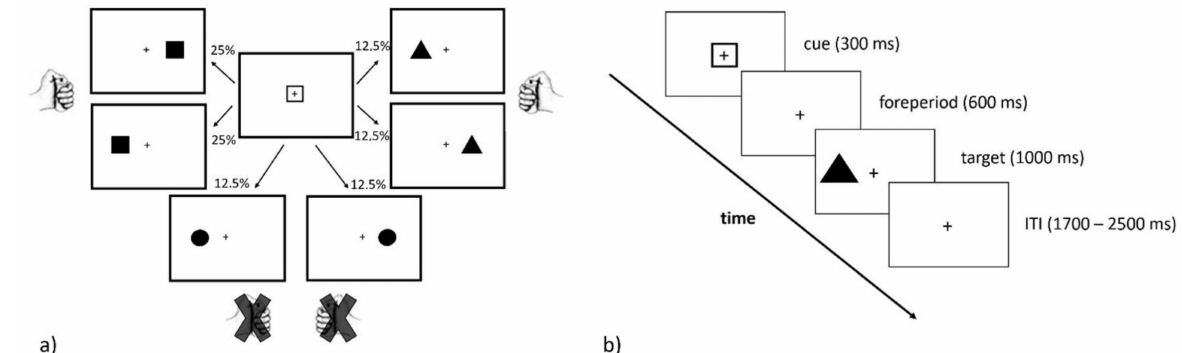
Figure 1. A visual representation of cue-target probabilities is displayed in ( a ). In this example, a squared central cue instructs participants to prepare a left-hand response. In 50% of the trials, a lateralized squared target was presented, requiring a left-hand button press. Such trials are termed valid cue Go trials. Conversely, a triangle target (presented in 25% of square cue trials, equiprobably on both side) required a contralateral (right-hand, in this example) button press, representing invalid cue Go trials. For both valid and invalid trials, the Go target can be presented ipsilaterally (compatible trials) or contralaterally (incompatible trials) to the required response. Finally, a NoGo circle target (presented in 25% of square cue trials, equiprobably on both side) requires for all participants to not respond. The central cue (empty square, triangle or circle) is presented for 300 ms, followed by a foreperiod of 600 ms. An example of invalid cue incompatible trial of the cued Go/NoGo Simon paradigm is shown in ( b ). In this example, the square instructs (half of the) participants to prepare a left-hand button press. Following a 600 ms-long foreperiod, a lateralized filled-shape target is displayed for 1000 ms, during which responses are collected. A stimulus’ location can be compatible or incompatible with the side of the required response (in this case, a triangle requires a right-hand response, but it is presented on the left side). Following a variable inter-trial-interval (ITI), a new trial starts. Colors are inverted for displaying